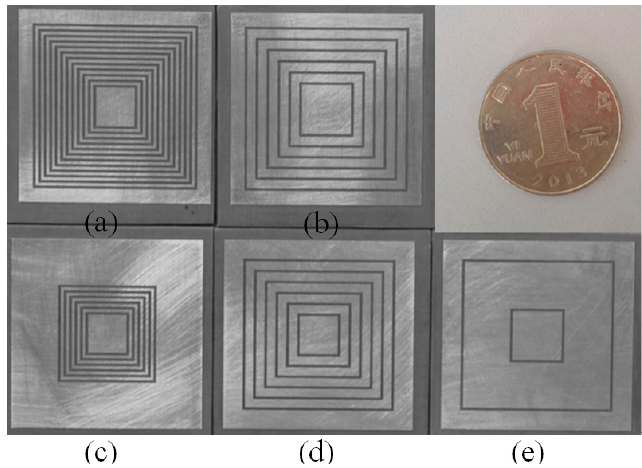
Figure 11. Photograph of the Rectangular slot ring tags with different IDs. ( a ) ‘111111111111 ′ , ( b ) ‘101010101010 ′ , ( c ) ‘000000111111 ′ , ( d ) ‘010101010101 ′ , ( e ) ‘010000000010 ′ .